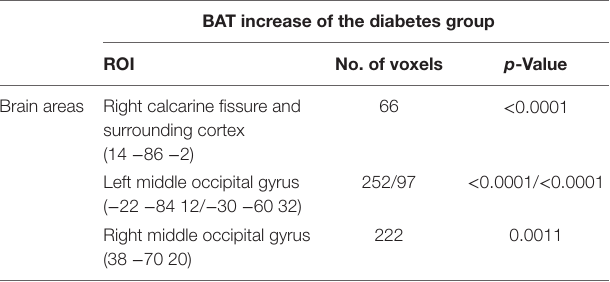
TaBle 2 | Areas with the most significant differences in the bolus arrival time (BAT) maps as obtained from the voxel-based analysis. BaT increase of the diabetes group rOi no. of voxels p -Value Brain areas Right calcarine fissure and surrounding